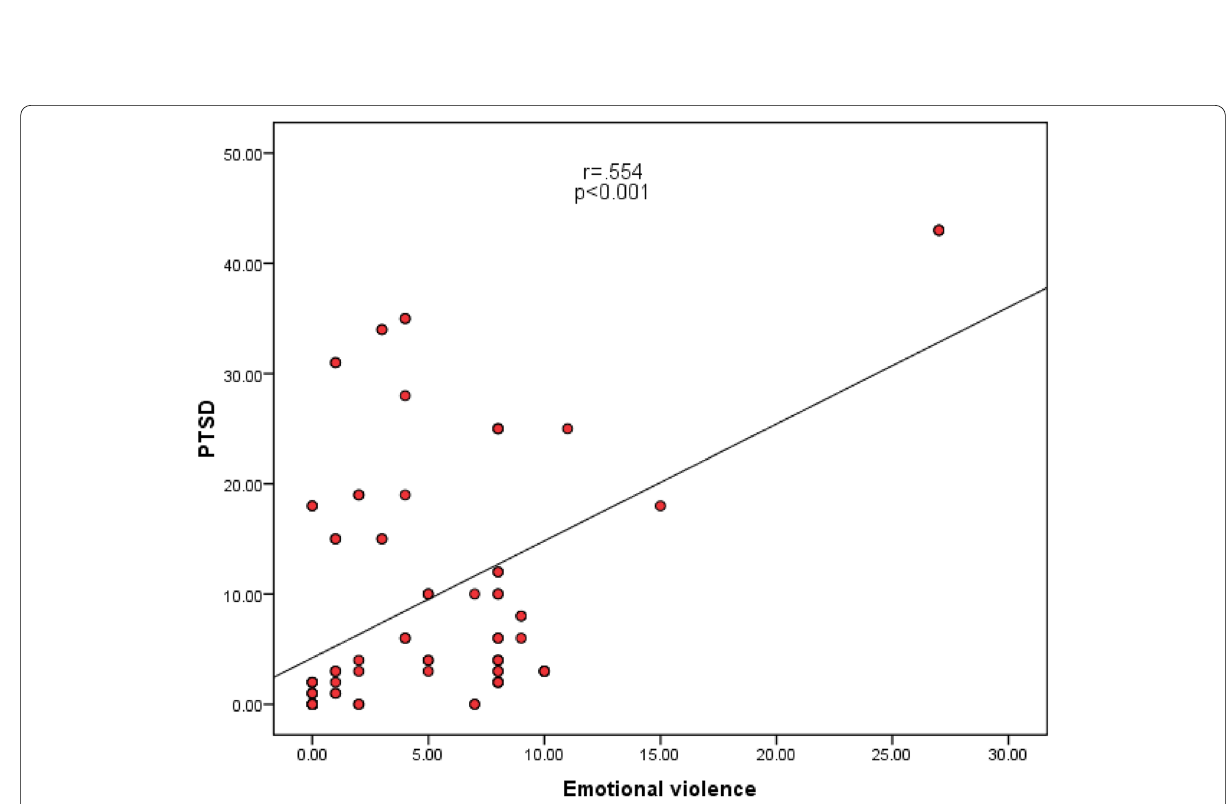
Fig. 2 Scatter diagram showing a correlation between emotional violence and post-traumatic stress